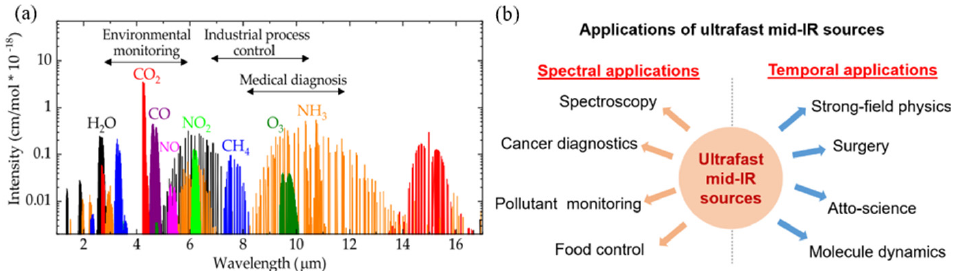
Figure 1. ( a ) Absorption spectra of gas molecules in the MIR region. Reprinted with permission from Ref. [7]. 2019, MDPI. ( b ) Application fields of ultrafast MIR sources.